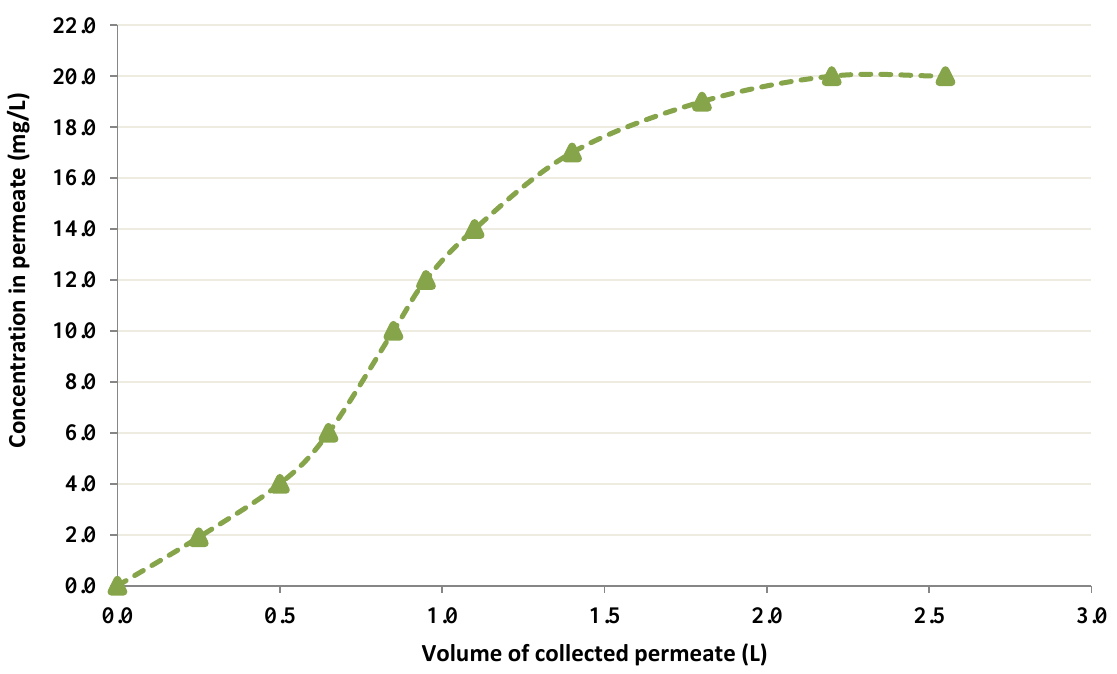
Figure 5. Permeation curve of Cobalt in the CEFP (Co feed concentration = 10 mg/L).